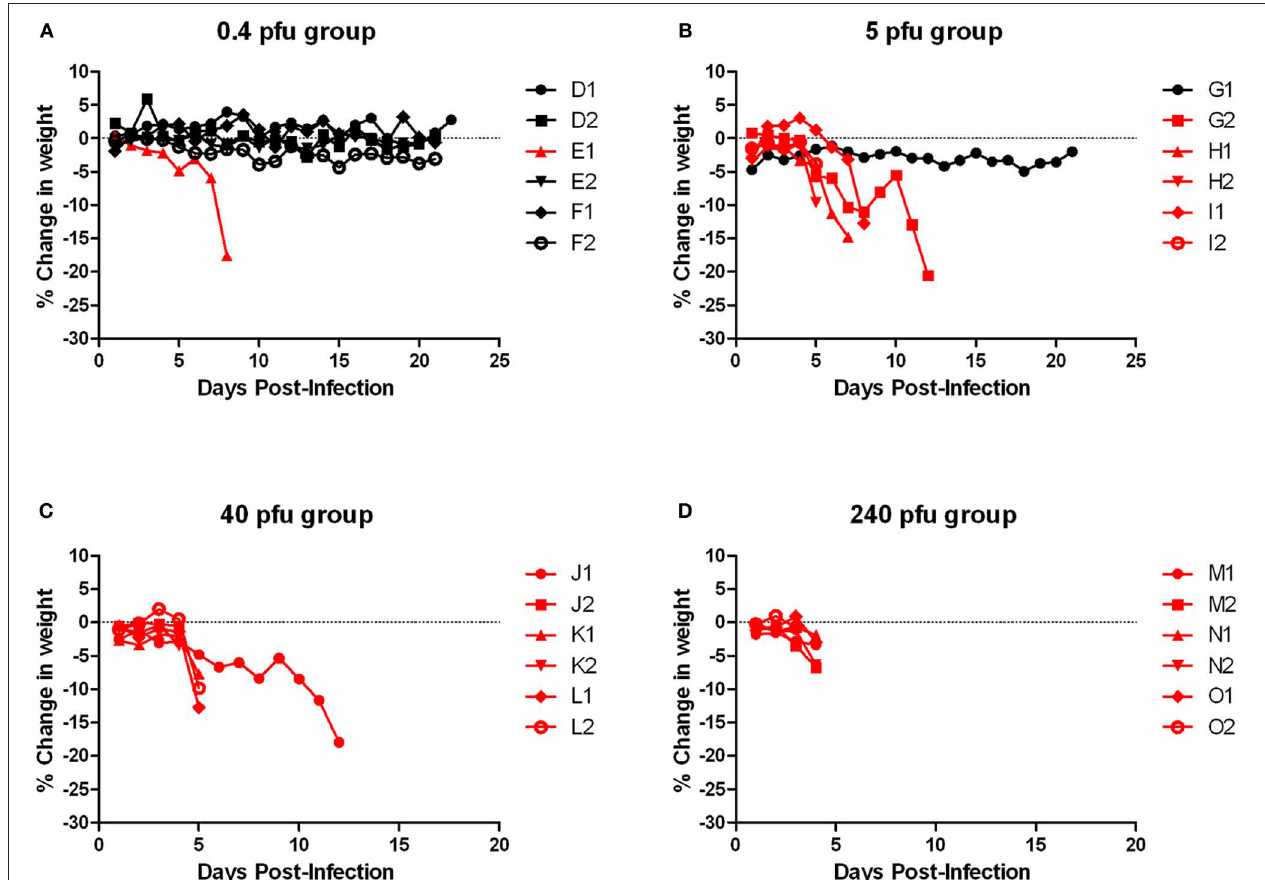
FIGURE 2 | Body weight of Wistar-Furth rats infected with aerosolized RVFV. Groups of six female Wistar-Furth rats were infected with RVFV by the aerosol route at four doses plus uninfected controls. (A) 0.4pfu/rat; (B) 5pfu/rat; (C) 40pfu/rat; (D) 240pfu/rat. The y -axis of each graph